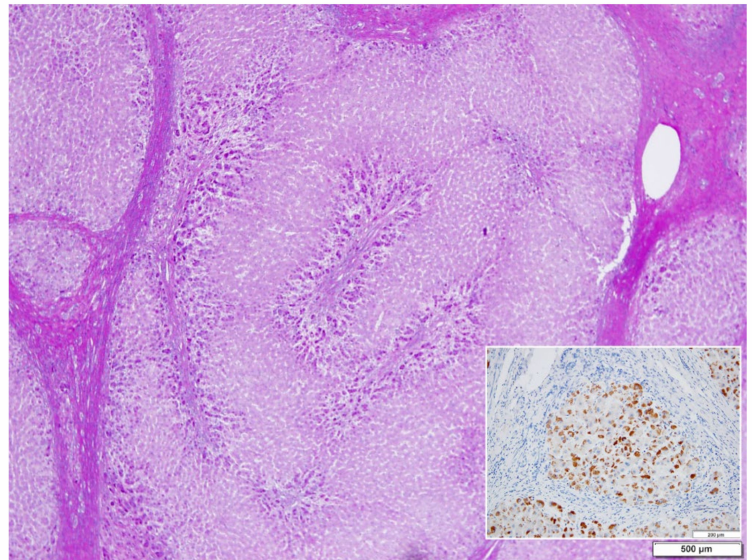
Figure 5. Pi ZZ explanted liver. A mixed type (uni- and multilobular) cirrhosis. PASD inclusions are present in zone 1 hepatocytes, separated from the connective tissue of the portal tracts by edema. PAD × 1.25. AAT inclusions fill up the entire hepatocytic cytoplasm in a small nodule. A few positive cells are scattered in the central part (Inset. AAT polyclonal immunostaining ×